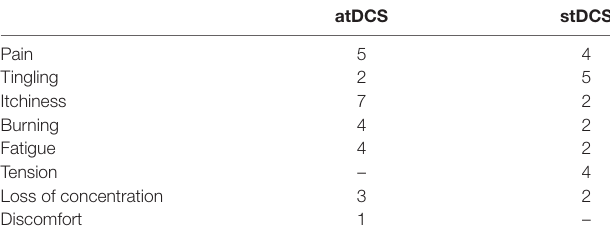
TABLE 3 | Number of participants who reported adverse effects (total N =